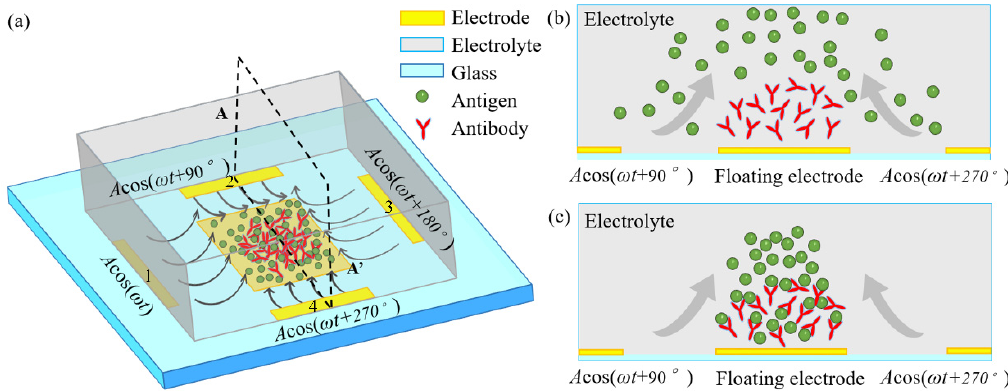
Figure 1. A systematic schematic of improving the specific binding reaction between immobilized antibodies and freely suspended antigens in the dilute electrolyte by induced-charge electroosmosis driven by an externally-imposed rotating electric field (ROT-ICEO) on the ideally polarizable surface of a central floating electrode (FE). ( a ) A 3D sketch for enhancing inhomogeneous immunoassay in a static microchamber; ( b ) fluidic samples before electrical powering; ( c ) electroconvective transport of antigens towards the functionalized FE surface accelerates the interfacial binding reaction.